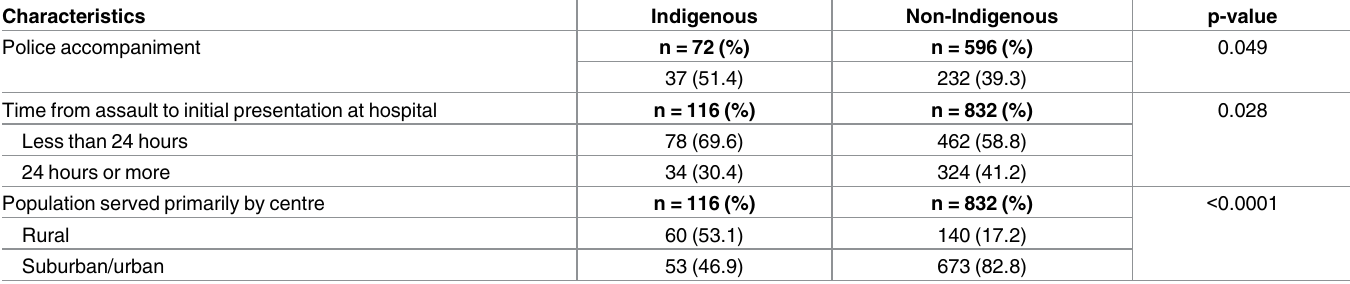
Table 1. Presentation characteristics of sexually assaulted adolescent and adult women who presented to Sexual Assault/Domestic Violence Treatment Centres, by Indigenous status.